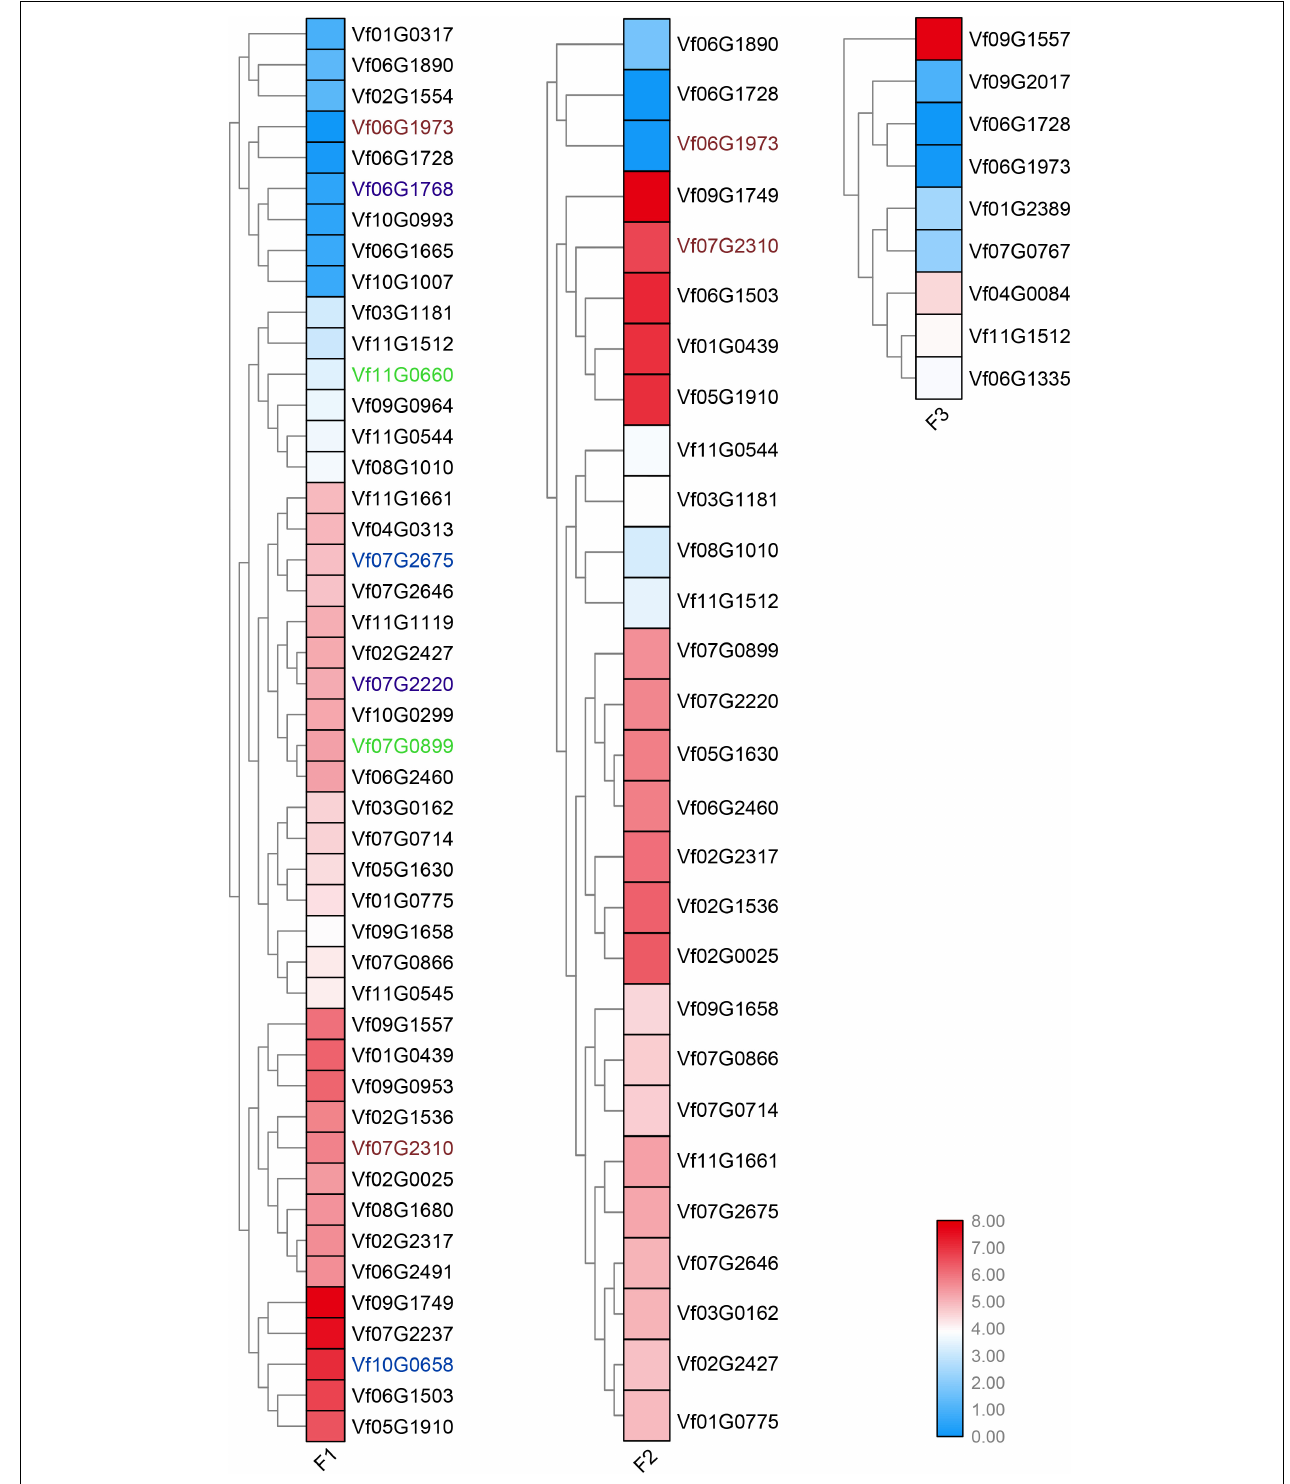
FIGURE 5 | Old duplicate genes involved in response to Fusarium wilt disease stress. The same color font suggests that a duplicate gene was simultaneously involved in Fusarium wilt disease stress over more than one periods.